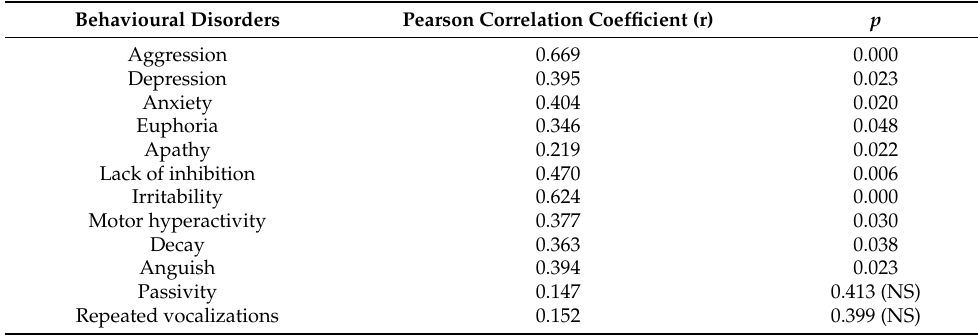
Table 7. Correlations between Burden and Behavioural